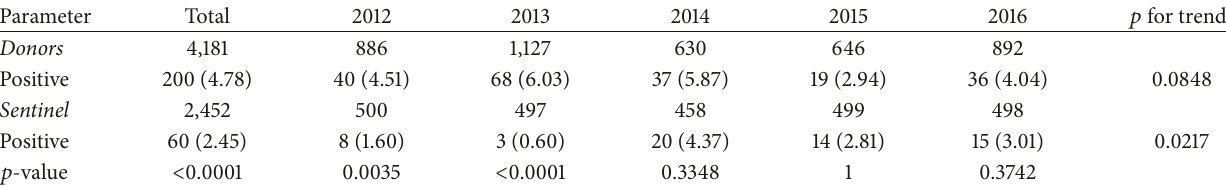
Table 1: Year-on-year prevalence of HIV infection among blood donors and pregnant women (Sentinel survey) in the Ho